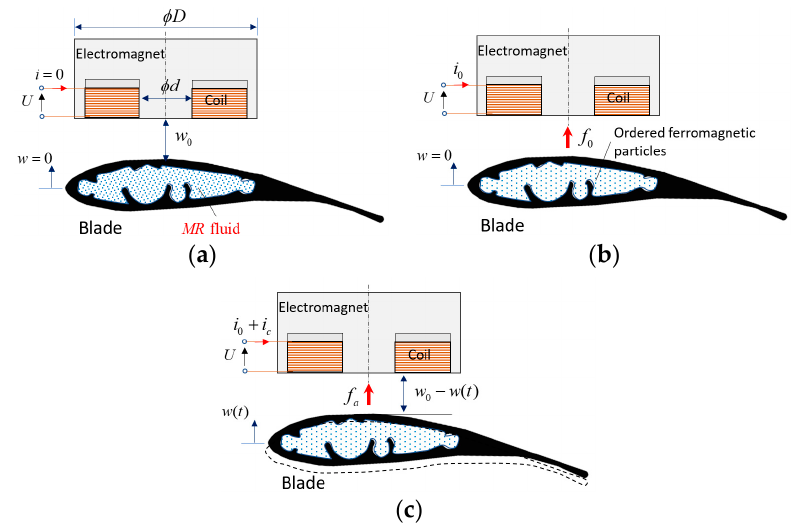
Figure 6. Illustration of the MR blade and electromagnetic actuator interaction ( a ) initial setting, ( b ) the application of the bias current i 0 , ( c ) the control force f a generation.